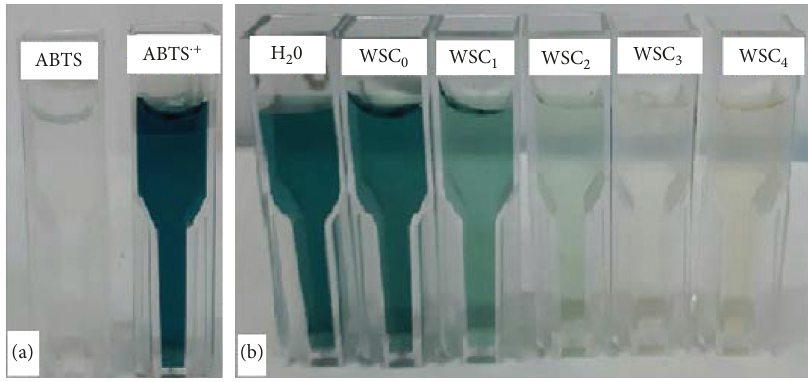
Figure 5: ABTS and ABTS • + solution (a) and ABTS • + with the presence of WSC and H